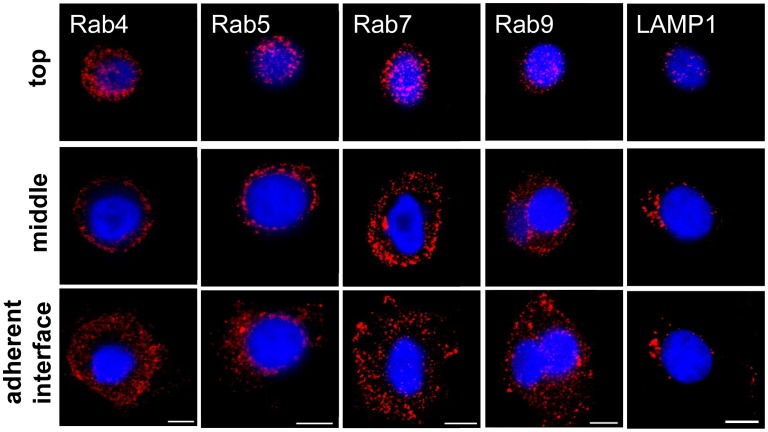
Distribution of intracellular vesicles in MCF7 cells.MCF7 tumor cells grown in glass-bottomed MatTek dishes for 48 h were fixed in paraformaldehyde, permeabilized and stained with primary antibodies specific for early (Rab4, Rab5), late (Rab7, Rab9) and recycling (Rab11) endosomes or lysosomes (LAMP1), followed by an appropriate Cy3-labeled secondary antibody (red). The nucleus was counter-stained with DAPI (blue). Representative three-frame composites from across the z-stack are shown. All of the vesicular markers assessed were found to be homogenously distributed throughout the cells. Objective 63×; scale bar 10 µm.